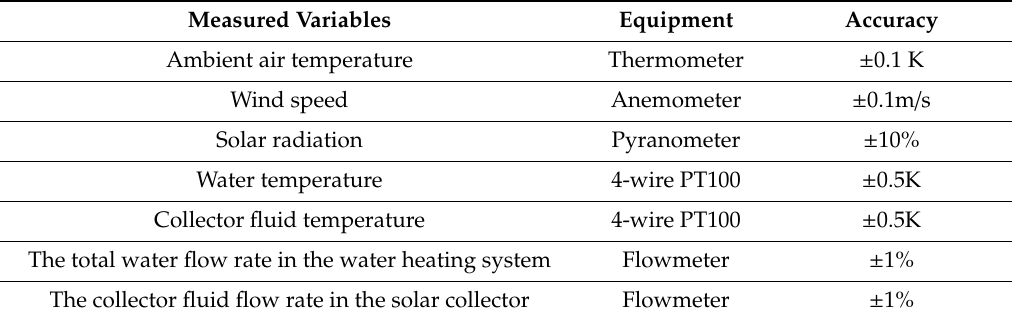
Table 1. The measurement variables, equipment and accuracy for the case